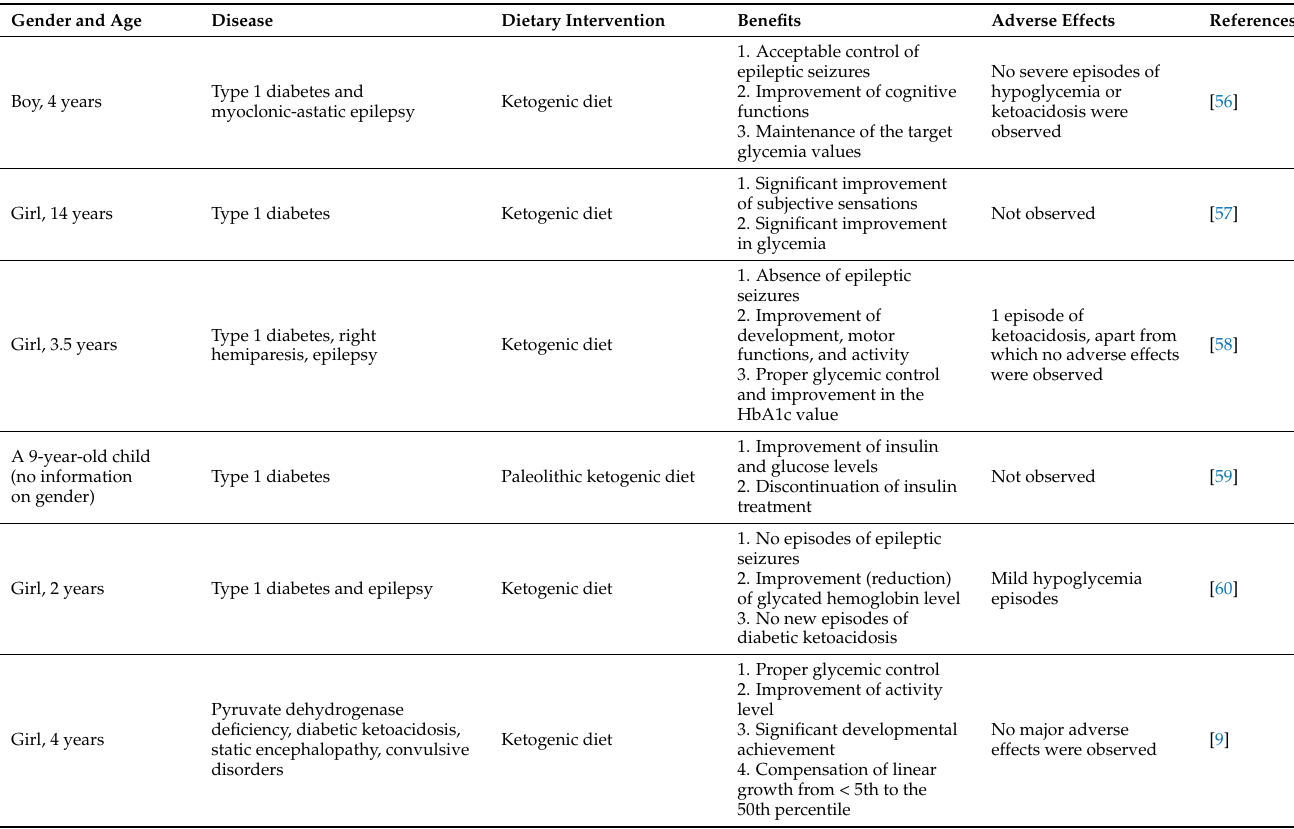
Table 1. Effect of ketogenic diets as prescribed for children with type 1